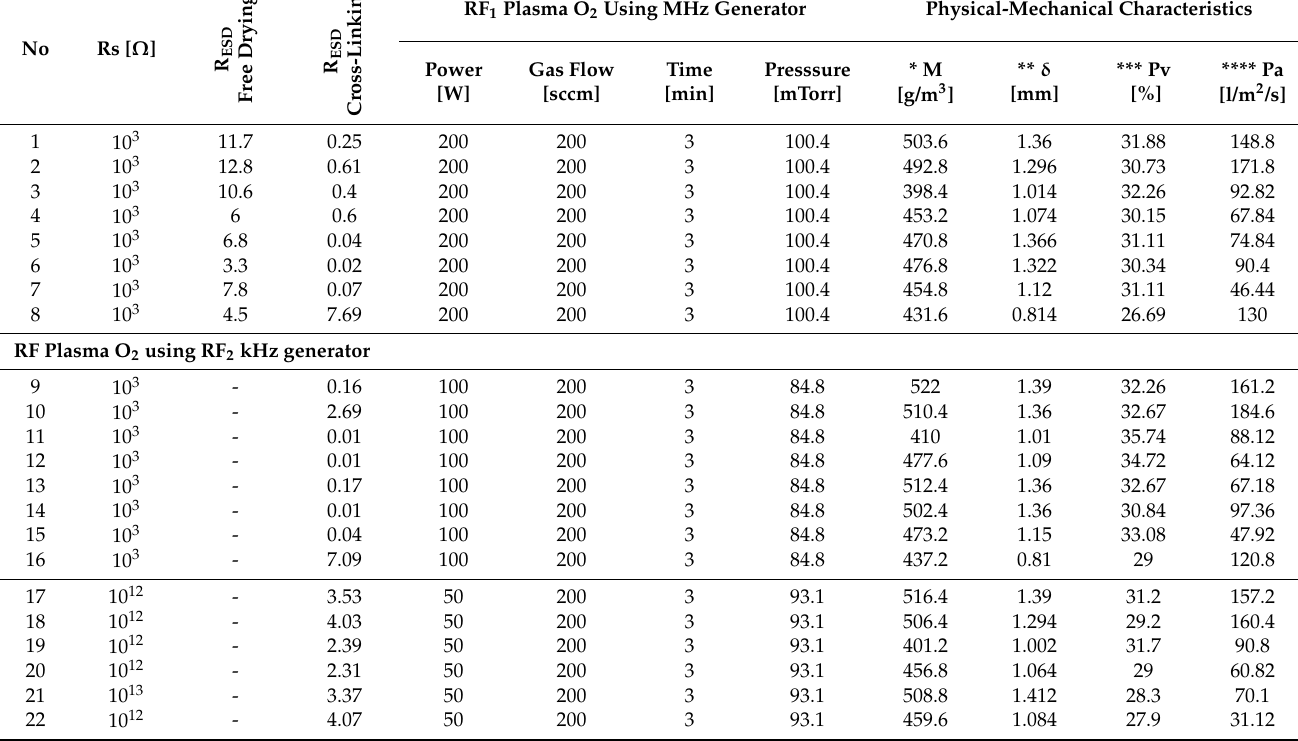
tension of 100 V. Table 1. RF O 2 plasma process parameters and electrical characterization of the samples after coating with polymeric pastes based on PVA and Ni microparticles.